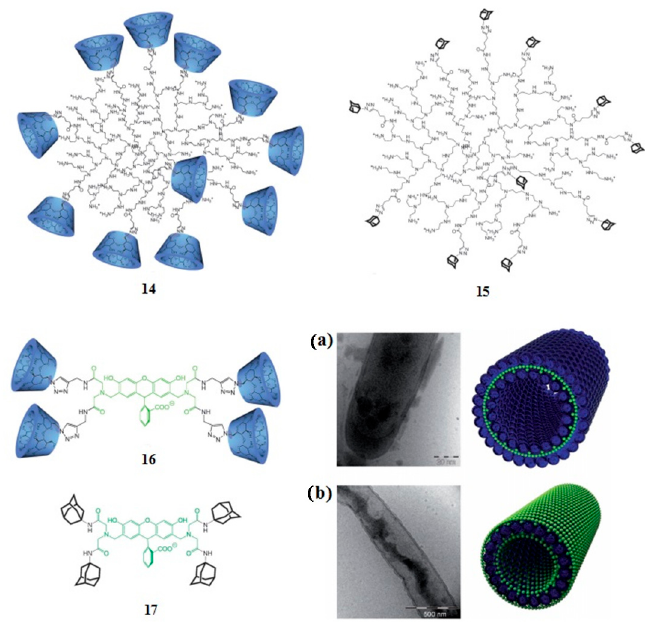
Figure 8. Structures of CD-PEI 14 , Ada-PEI 15 , CD-Cal 16 , and Ada-Cal 17 . ( a ) Cryo-TEM of tubular vesicles prepared from CD-PEI 14 (blue)/Ada-Cal 17 (green); and ( b ) Ada-PEI 15 (blue)/CDCal 16 (green). Reprinted with permission from [74]. Copyright 2011, Wiley-VCH.